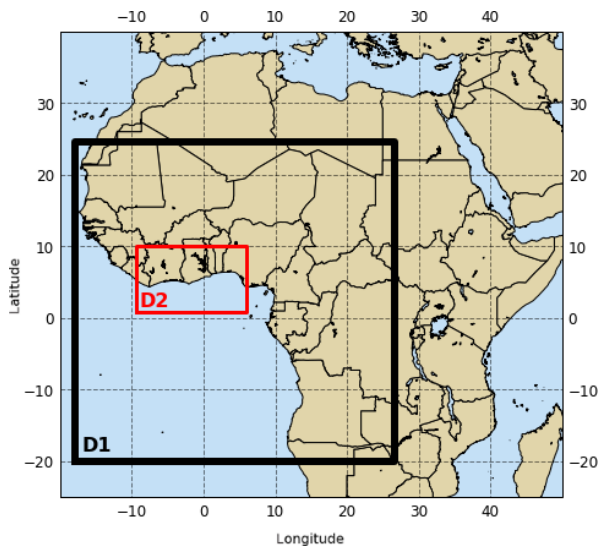
Figure 2. The two nested domains used by the COSMO-ART